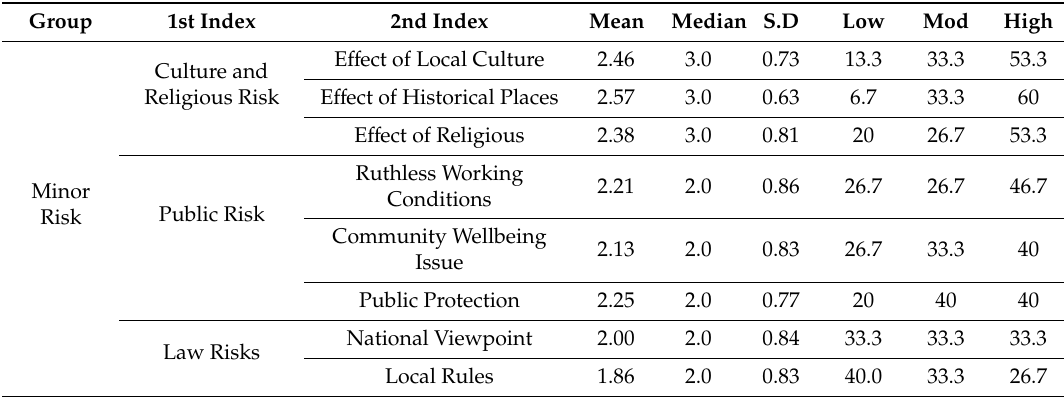
Table 5. Minor-level risk for round